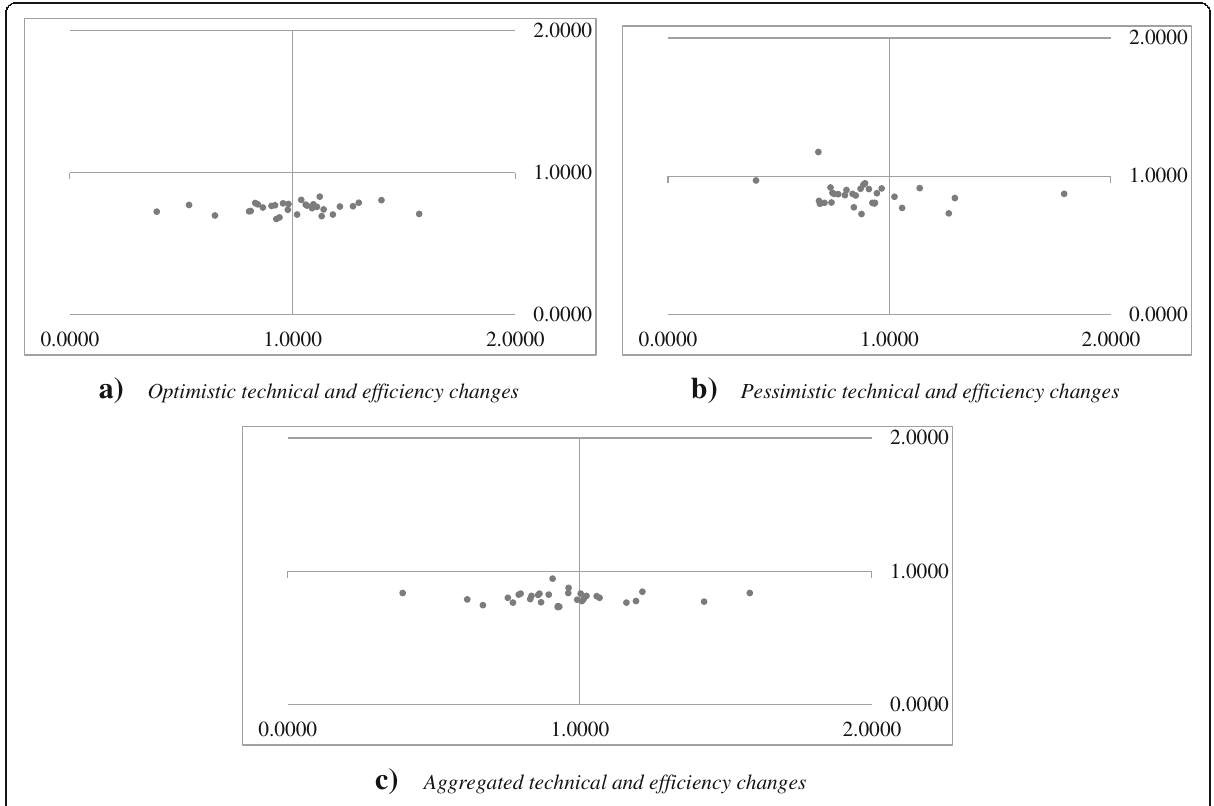
Fig. 9 The results of negative or positive productivity growth in connection with technical and efficiency changes for the 31 Iranian provinces from 2014 – 2016. Vertical axes: efficiency change. Horizontal axes: technical change